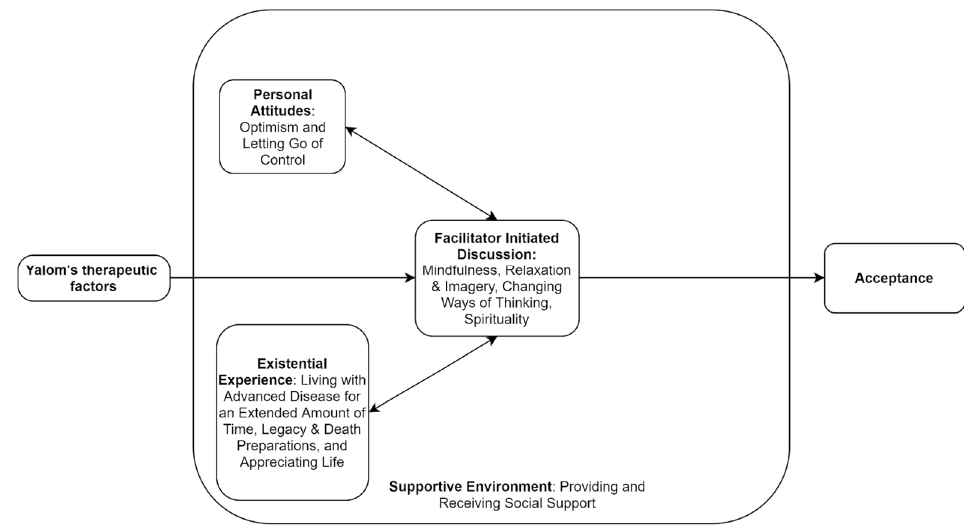
Figure 1. The summary and relationship between themes and sub-themes that contributed to the emergence of acceptance in Online Support Group (OSG) participants.